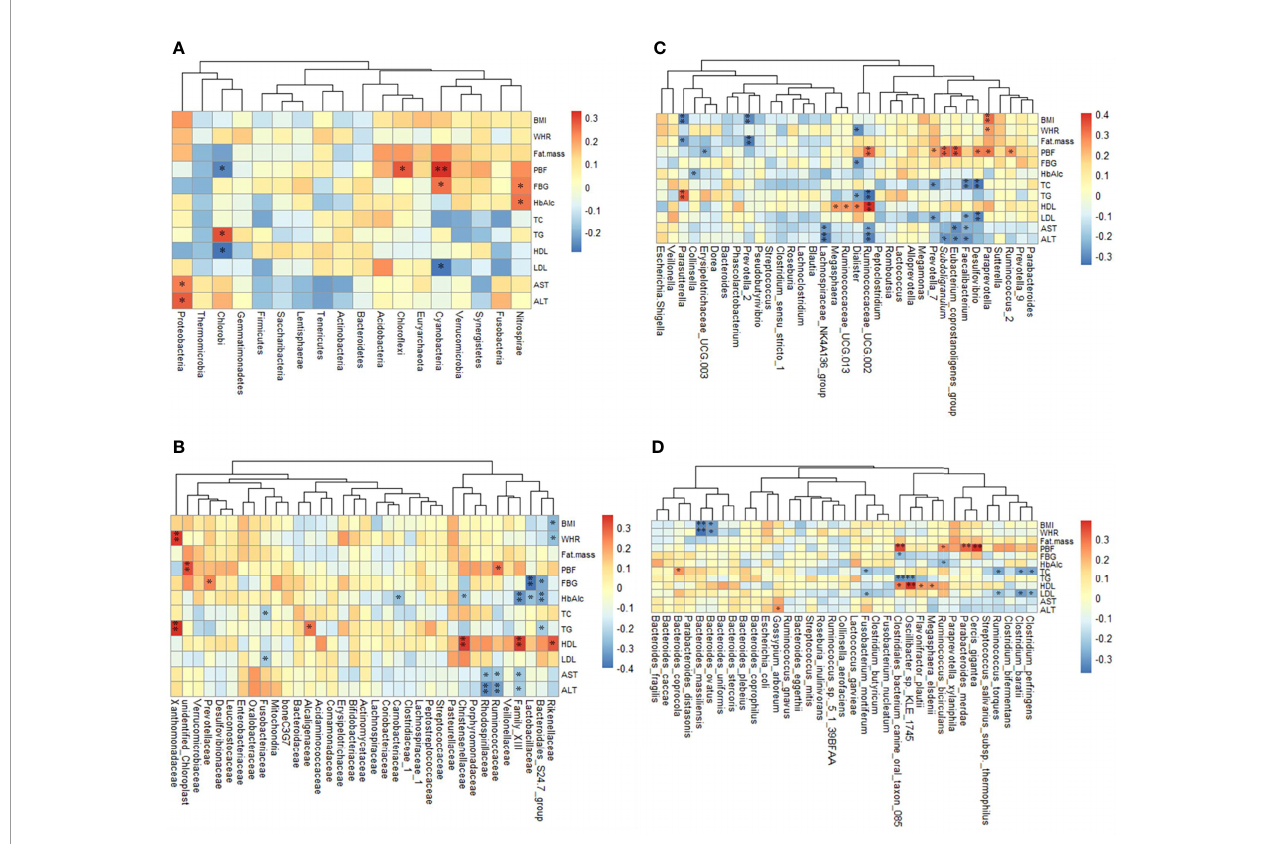
FIGURE 5 | The relationship between obesity indexes or/and blood parameters and taxon across groups is estimated by Spearman ’ s correlation analysis. (A) The 18 top altered phylum, (B) the 35 top family, (C) the 35 top genera, (D) the 35 top genera species. * p < 0.05 and ** p <